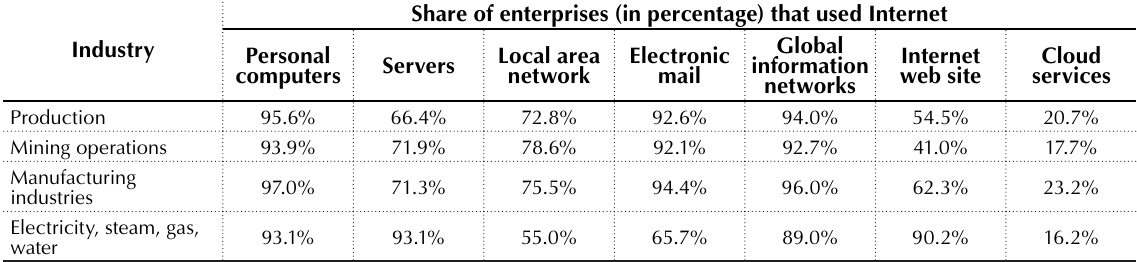
Table 1. First stage: primary information and communication digitization in Russia as of 2017